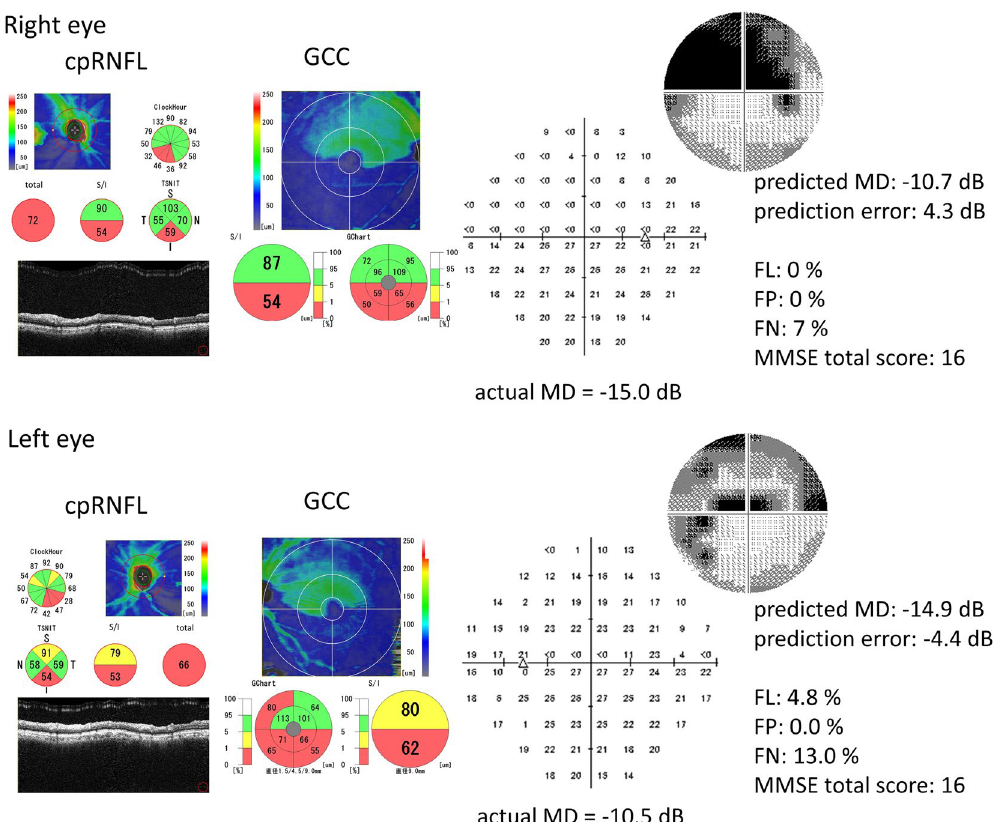
Figure 1. A case example (86 year old male). MD values were predicted from OCT determined cpRNFL thickness and average GCC thickness through the leave-one-out cross-validation; the predicted MD value was calculated from the remaining 50 patients (92 eyes). Despite the reliable FL, FP and FN results, a markedly over- (right eye) and under- (left eye) prediction was obtained. This patient had the lowest MMSE total score (16). MD: mean deviation, OCT: optical coherence tomography, cpRNFL: circumpapillary retinal nerve fiber layer, GCC: ganglion cell complex, FL: fixation loss, FP: false positive, FN: false negative, MMSE: Mini Mental State Examination.